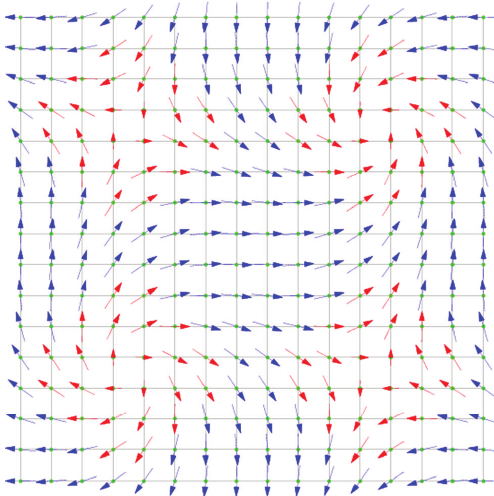
Figure 3: ( Color online ) The ground state configuration for a 16 × 16 unit cell with the strength of the periodic potential (in units, where J = 1) being V = 3 . 0, and the Hubbard interaction is U = 8 . 0. The lengths of the spins denote their planar projection. Note a vortex/antivortex at the center of each